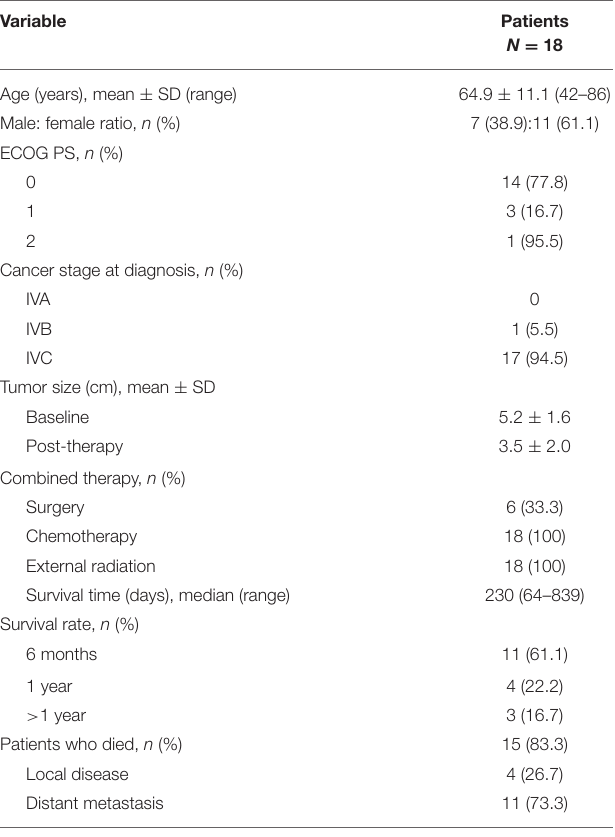
TABLE 1 | Patient characteristics and clinical